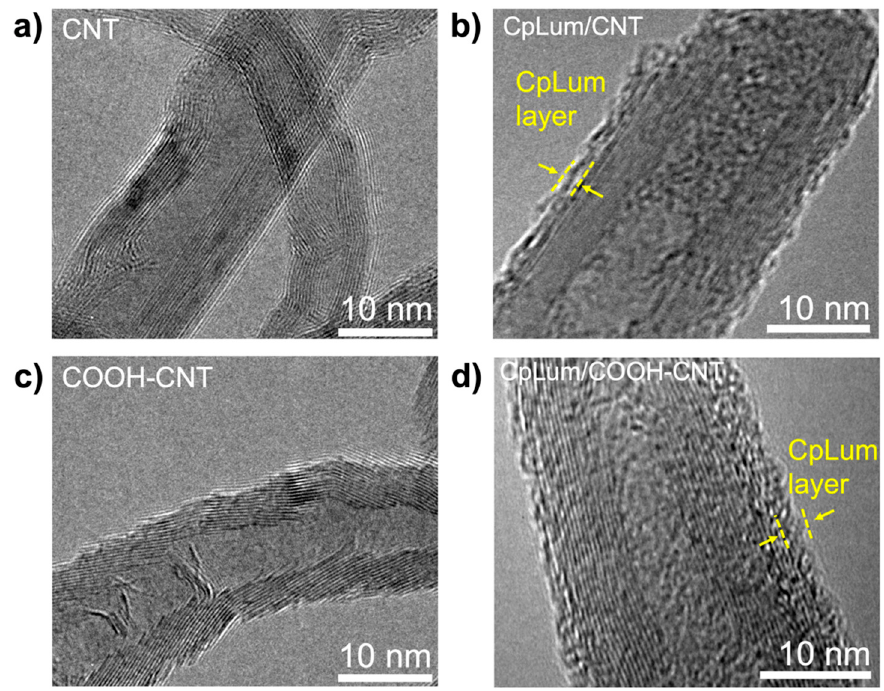
Figure 4. TEM images of ( a ) CNT, ( b ) CpLum/CNT, ( c ) COOH-CNT, and ( d ) CpLum/COOH-CNT. Table 3. Elemental survey normalized atom percentages of C1s, O1s and N1s.